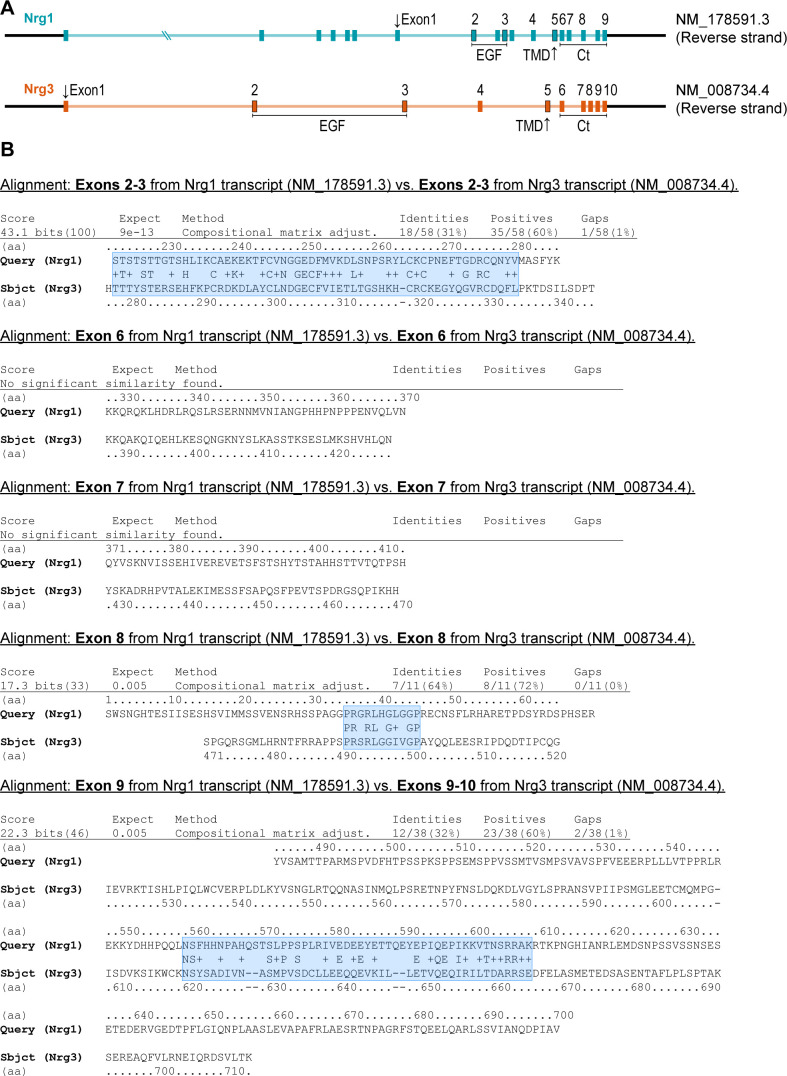
Comparison of amino acid sequences of the EGF-like domain and the C-terminal domains of Nrg1 and Nrg3.(A) Schematic representation of genomic sequences for Nrg1 and Nrg3 loci. Numbers correspond to exons. The specific gene isoform for Nrg1 and Nrg3 are indicated (right). (B) Sequence alignments of Nrg1 and Nrg3 for exons 2–3, which correspond to the EGF-like domain, and exons 6–10, which correspond to the C-terminal domain. Ct: C-terminal domain; EGF: EGF-like domain; TMD: transmembrane domain.